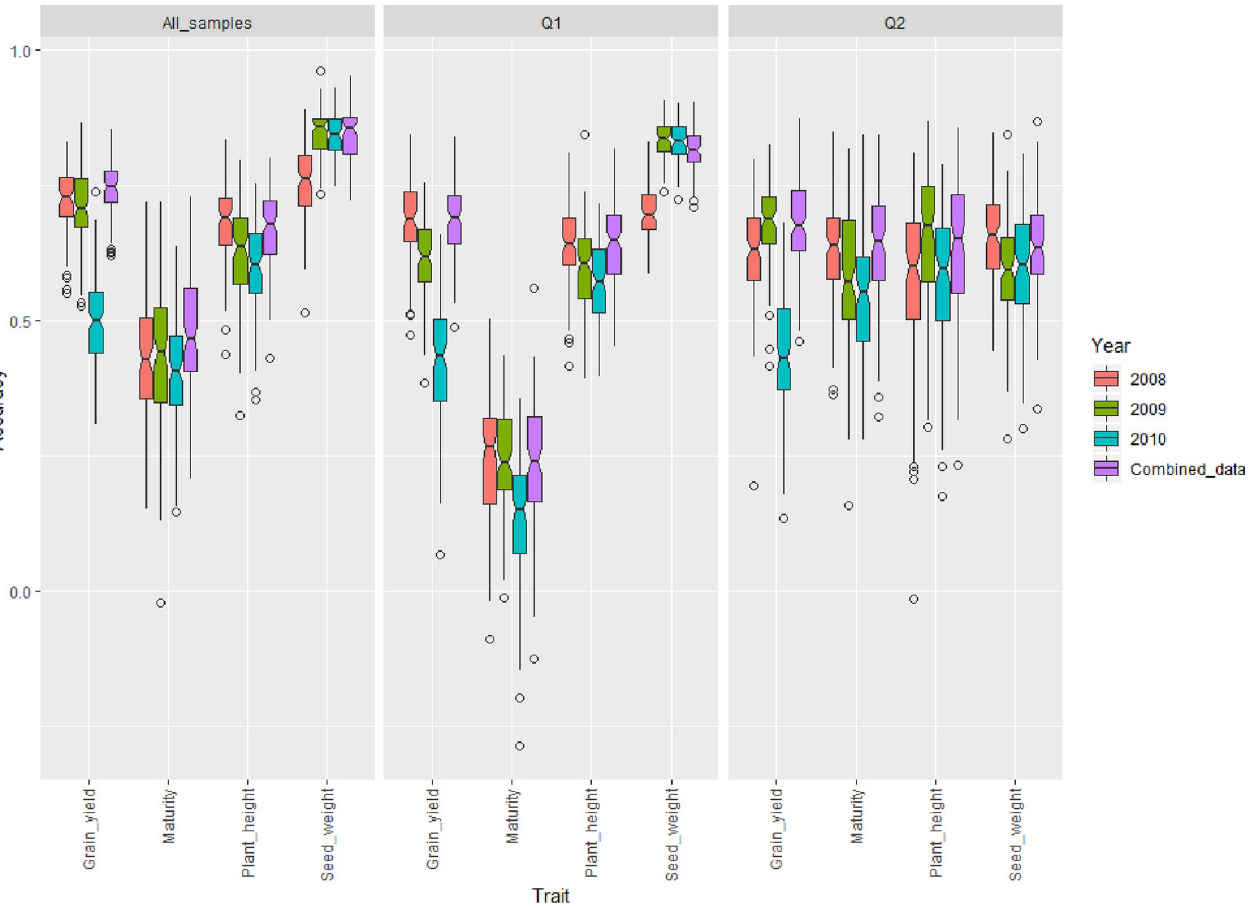
Fig 2. Genomic selection accuracy for yield, maturity, plant height, and seed weight using training/testing sets from all 250 soybean accessions (all samples), samples derived from Q1, and samples from the Q2 subpopulation. Cross-validation was conducted using the data from the same year.